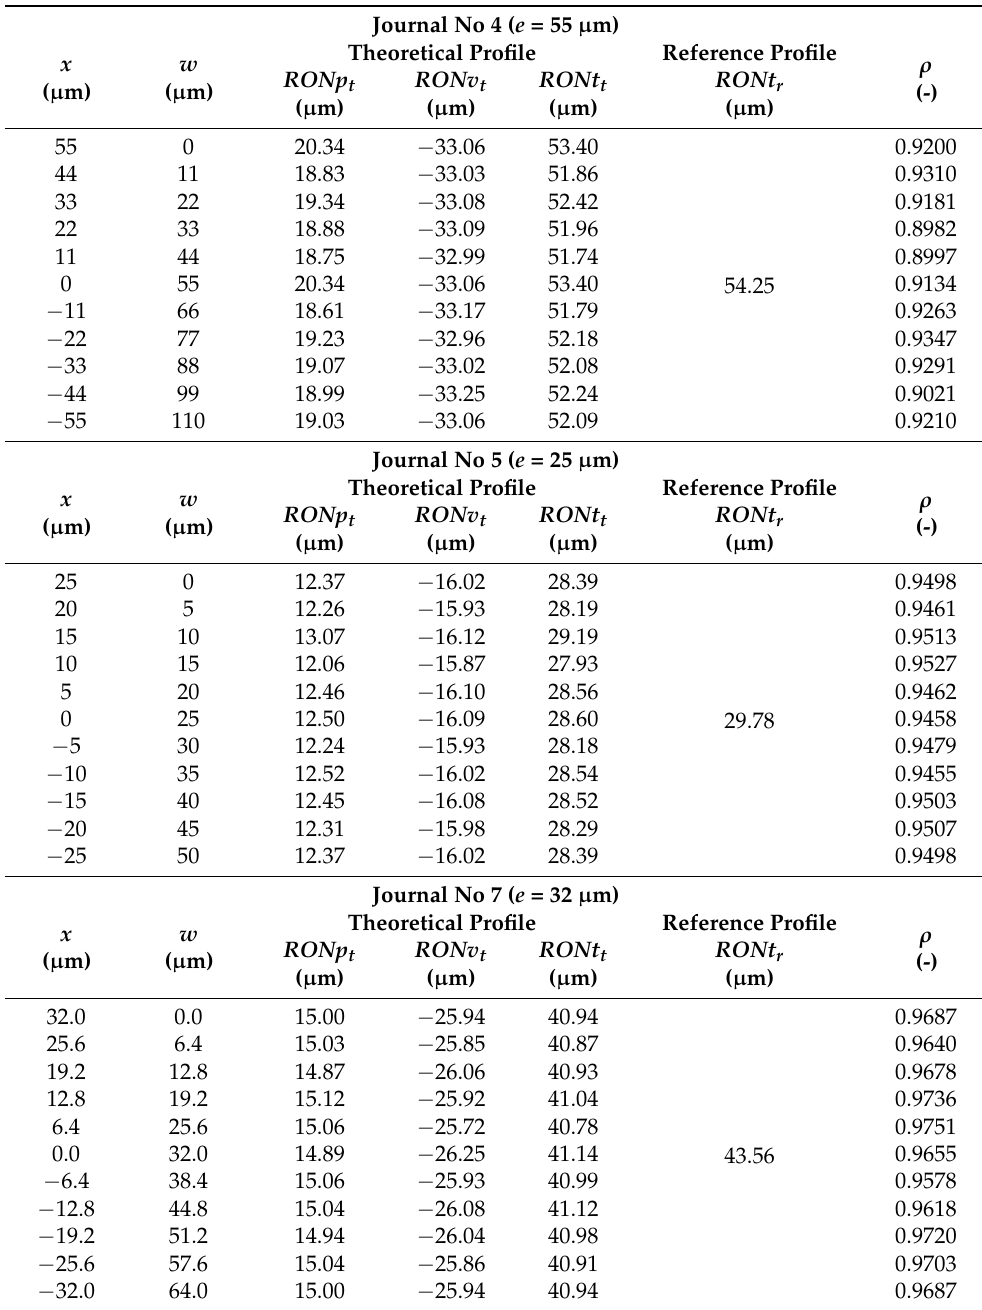
Table 5. Values of the roundness deviations of the journals numbered four, five and seven determined for the measured summary profiles ( RONt z ) and the obtained theoretical profiles ( RONt t ) depending on the changes of height position of supports x and values of intercorrelation factor ρ